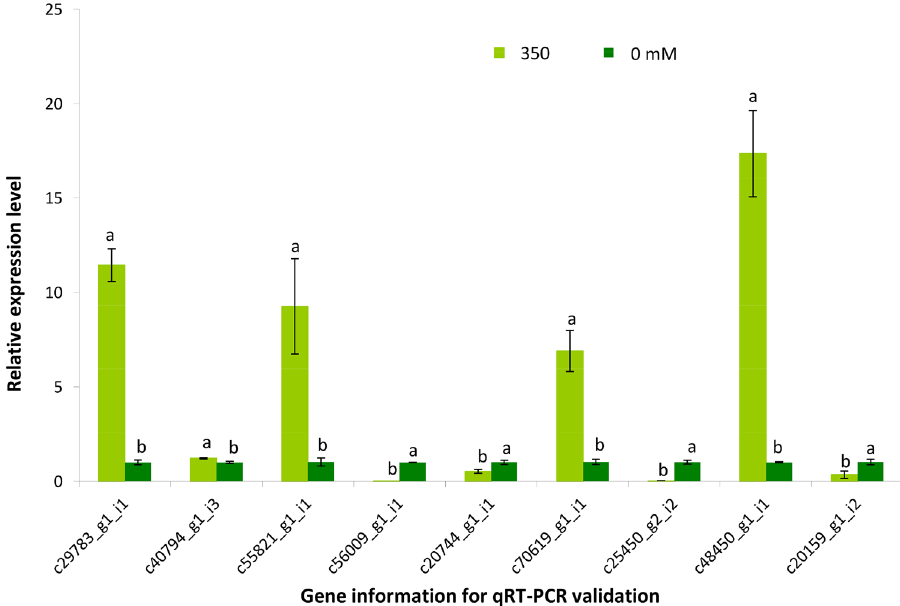
Figure 1. Validation of differentially expressed genes (DEGs) obtained from comparison of 350 mM NaCl treated plants shoots and control plants shoots using qRT-PCR. Each panel shows the qRT-PCR results for nine amplified genes. The gene information for qRT-PCR validation is listed on the X-axis and the mean fold changes represented by the 2 −ΔΔCt method relative to 0 mM treated samples are shown on the Y-axis. Error bars depict the standard error of the mean for three biological replicates. Significant differences between 350 mM NaCl treated plants and control of each gene ( p < 0.05) are denoted with lowercase “a” and